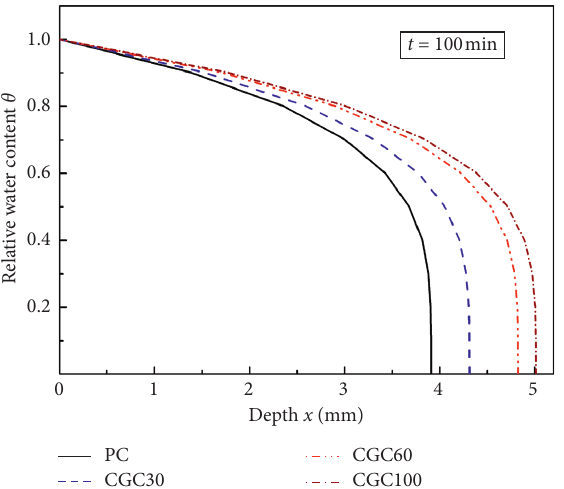
Figure 8: Influence of coal gangue ceramsite dosage on water penetration depth.